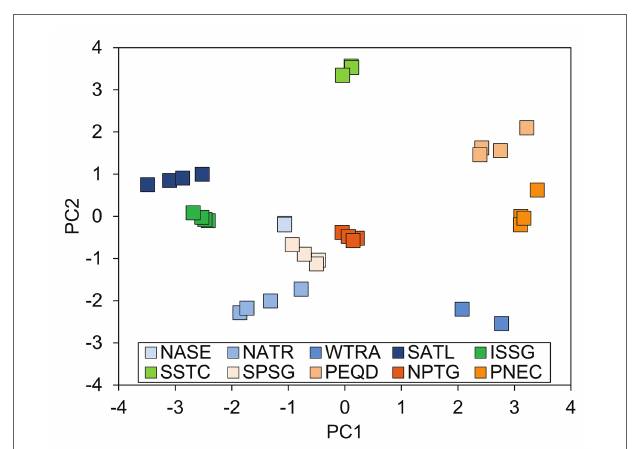
FIGURE 6 | Projection of samples on the space of the first (PC1) and second (PC2) components of the principal component analysis (PCA) of environmental variables (DCM: depth of the chlorophyll maximum (m), δ 15 N 40–200 : natural abundance of microplankton nitrogen isotopes (‰), PP: annual mean primary production (mg C m −2 d −1 ), MLD: mixed layer depth (m), C 40–200 : microplankton